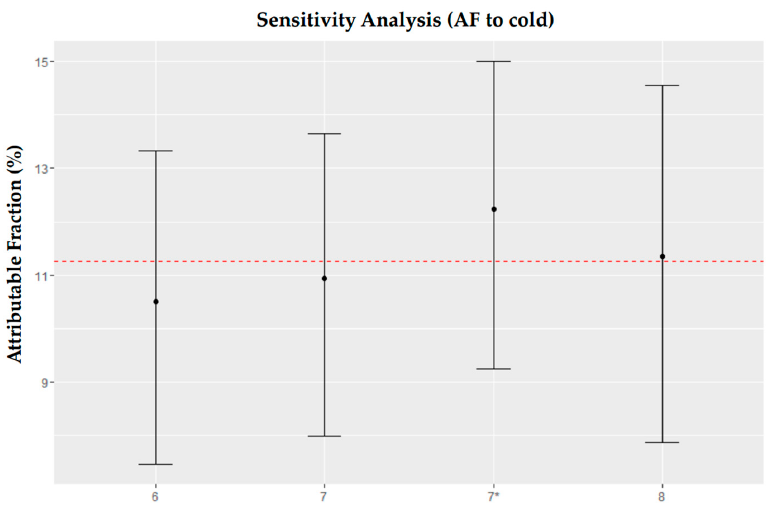
Figure A1. Attributable risk (AR) of cold for different degrees of freedom. * indicates pollutants and meteorological data were added to the model using a value of for the DF of time. The dashed line is the mean AR of the four groups.